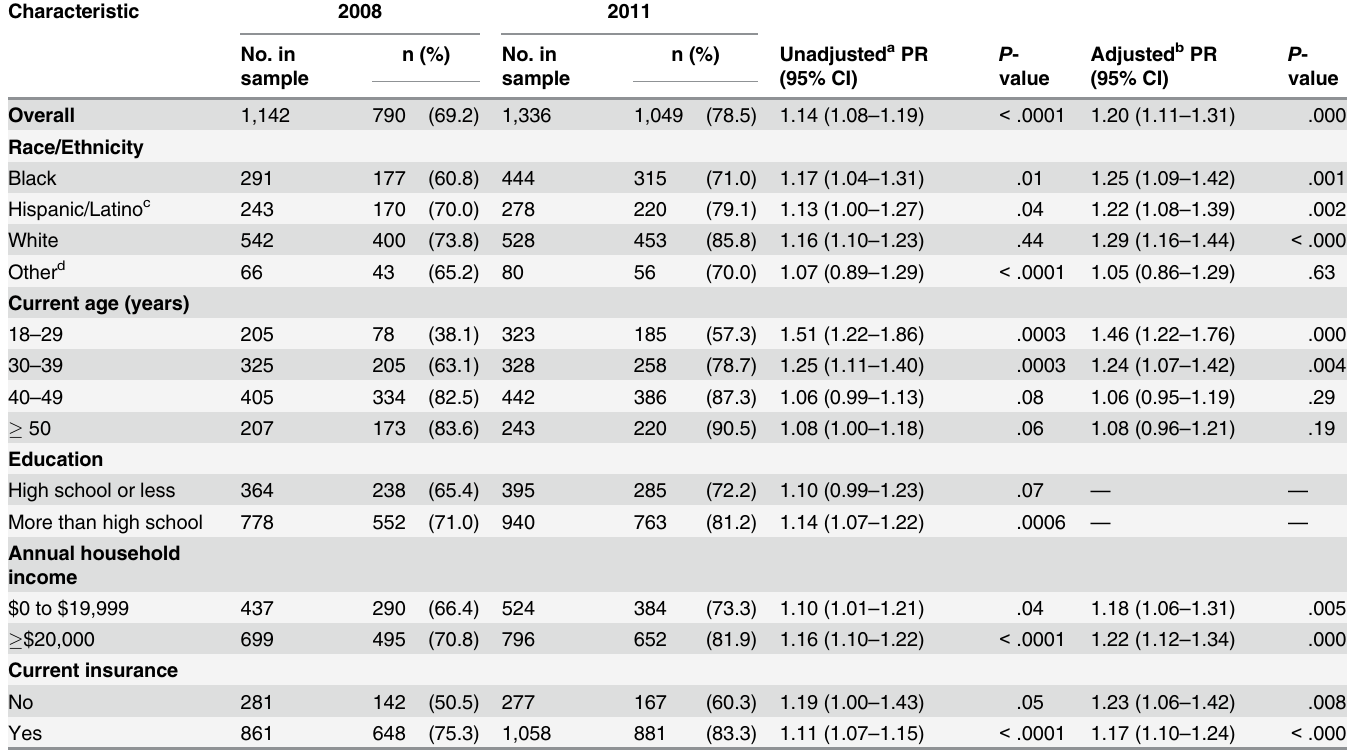
Table 4. Prevalence of current ARV treatment and prevalence ratios comparing prevalence of current ARV treatment in 2011 to 2008 among MSM – NHBS.